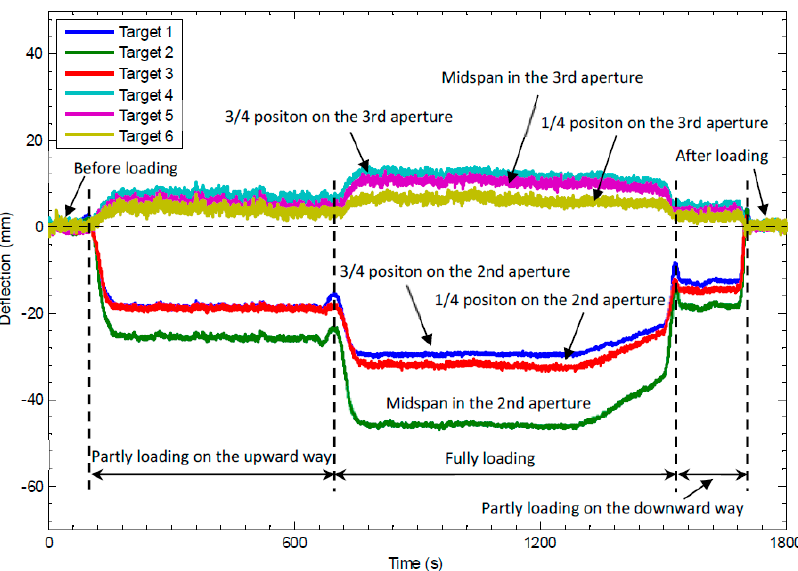
Figure 8. Measured deflection-time curves for the six targets.